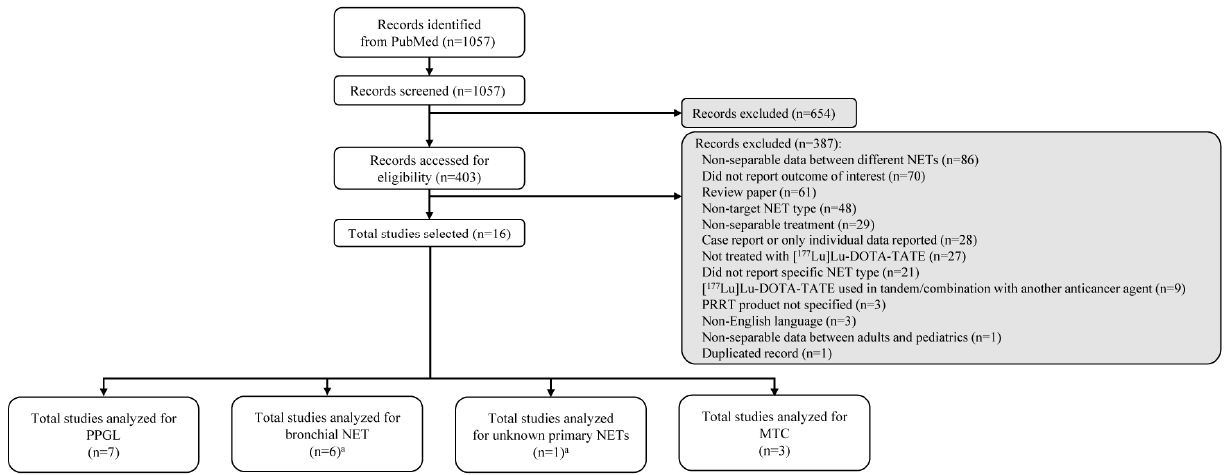
Figure 1. Summary of literature search. a One publication reported data for bronchial and unknown primary NETs. MTC—medullary thyroid carcinoma; NET—neuroendocrine tumor; PPGL—pheochromocytoma/paraganglioma; PRRT—peptide receptor radionuclide therapy.